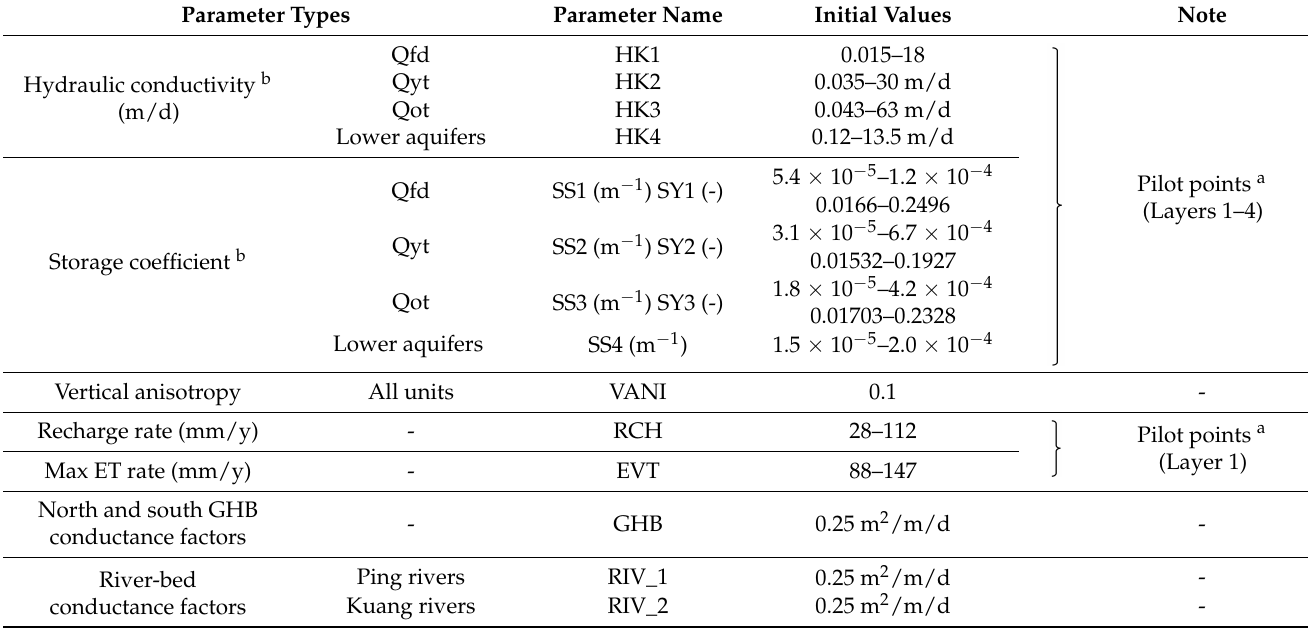
Table 2. Initial model parameter